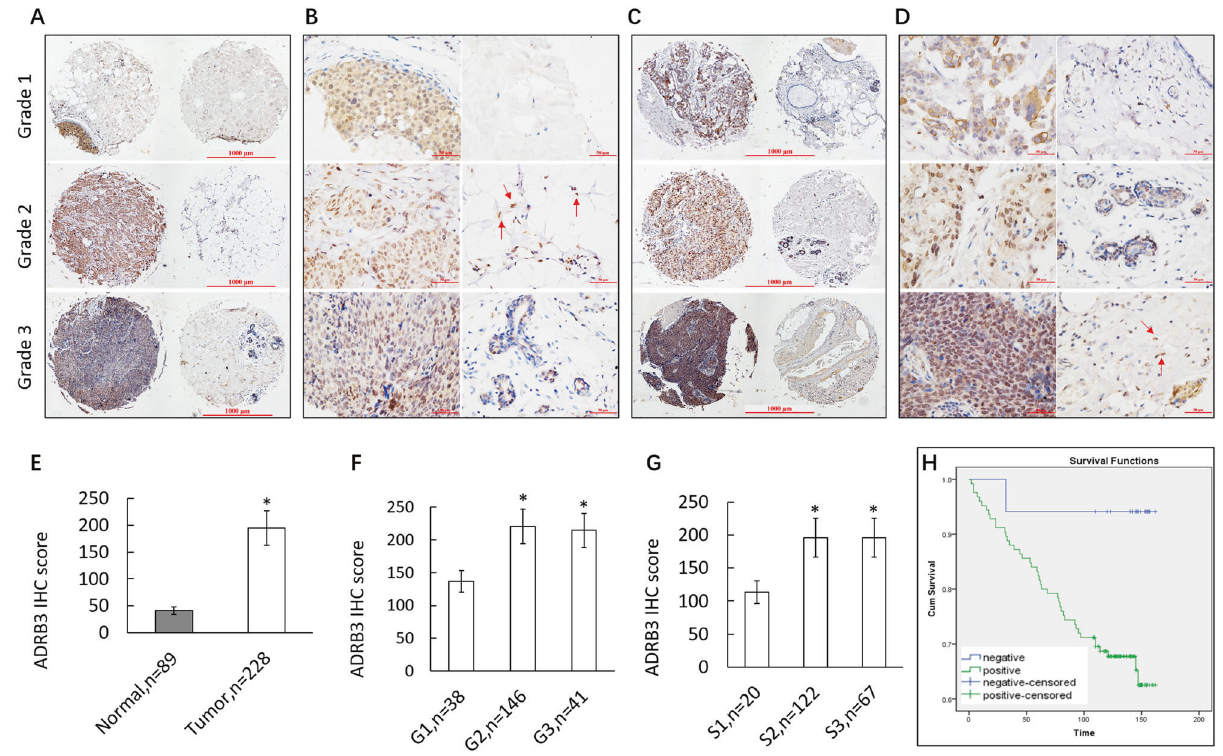
Fig. 1 ADRB3 expression in breast cancer. A , B Representative tissue spots of ADRB3 expression in cancerous tissue and paracancerous tissue of different grade in non-TNBC. Each row represents two specimens from the same patient; the left is cancerous tissue, the right is paracancerous tissue, bars = 50 μ m. Red arrows indicate macrophages. C , D Representative tissue spots of ADRB3 expression in cancerous tissue and paracancerous tissue of different grade in TNBC. Each row represents two specimens from the same patient; the left is cancerous tissue, the right is paracancerous tissue, bars = 50 μ m. Red arrows indicate macrophages. E The ADRB3 staining score was signi fi cantly increased in cancerous tissues (194.2 ± 32.6) compared with adjacent normal tissues (41.7 ± 6.8), * P < 0.01. F Poorly differentiated BC samples showed higher ADRB3 protein expression, compared with those well-differentiated BC samples, * P < 0.01. G The ADRB3 staining score was signi fi cantly increased along with more advanced TNM stage in BC tissues, * P < 0.01. H Kaplan – Meier curves of the overall survival of 142 breast cancer patients with negative or positive ADRB3 expression. The ordinate is the cumulative survival rate, and the abscissa is the survival time